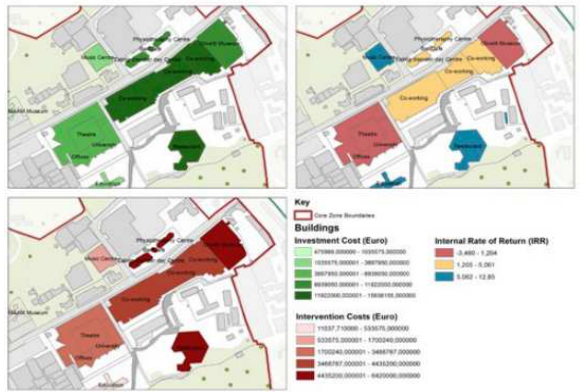
Figure 11. Ivrea, thematic map representing investment and project costs (Barreca et al.